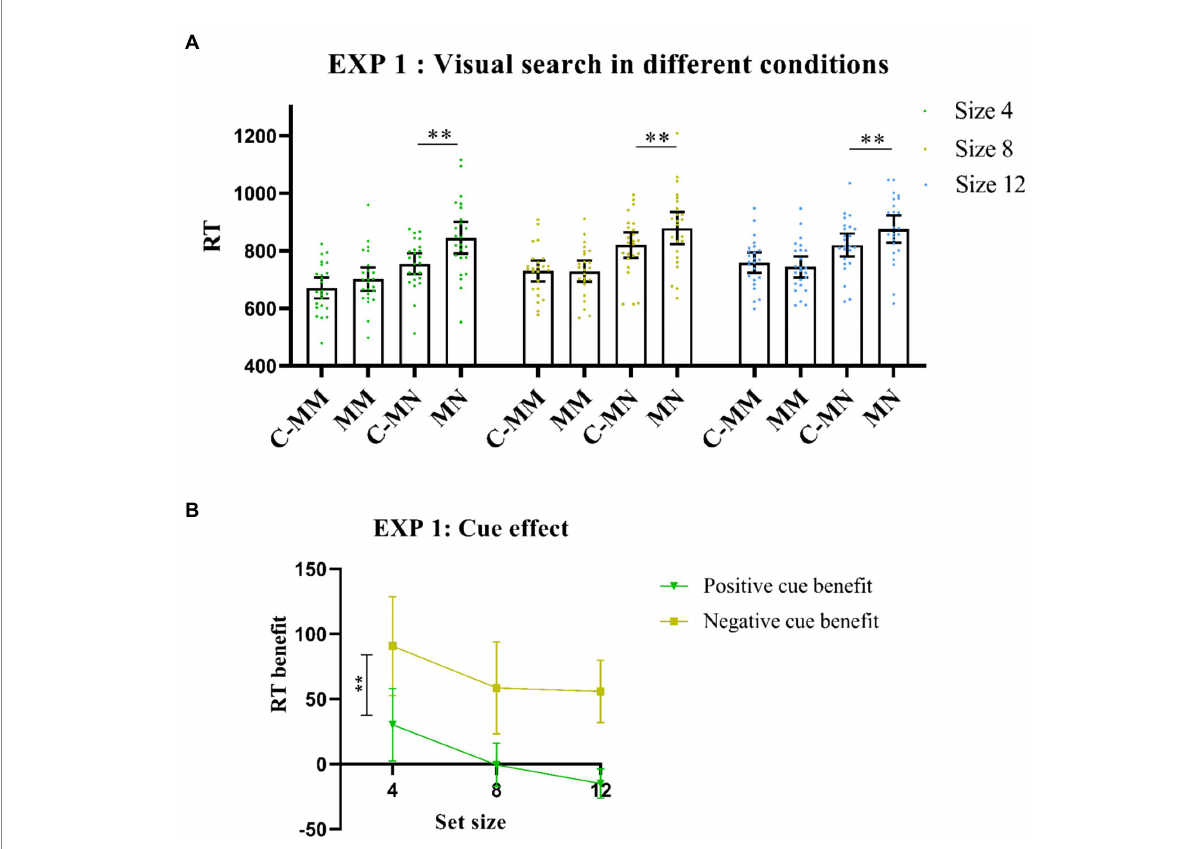
FIGURE 2 (A) Visual search performance in all Experiment 1 conditions. MM: memory-item-target-match; MN: memory-item-non-target-match; C-MM: cue-memory-item-target-match; CMN: cue-memory-item-non-target-match. ** p < 0.001. Error bars represent 95% within- subjects confidence intervals, as described by Loftus and Loftus (1988). (B) Cue benefit in Experiment 1. ** p < 0.001. Error bars represent 95% within-subjects confidence intervals, as described by Loftus and Loftus (1988). Positive cue benefit = MM-CMM(RT); Negative cue benefit =